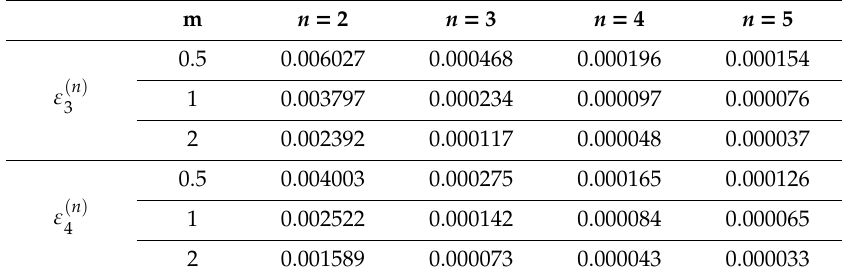
Table 1. Maximum computational errors when calculating the convolutions for s =